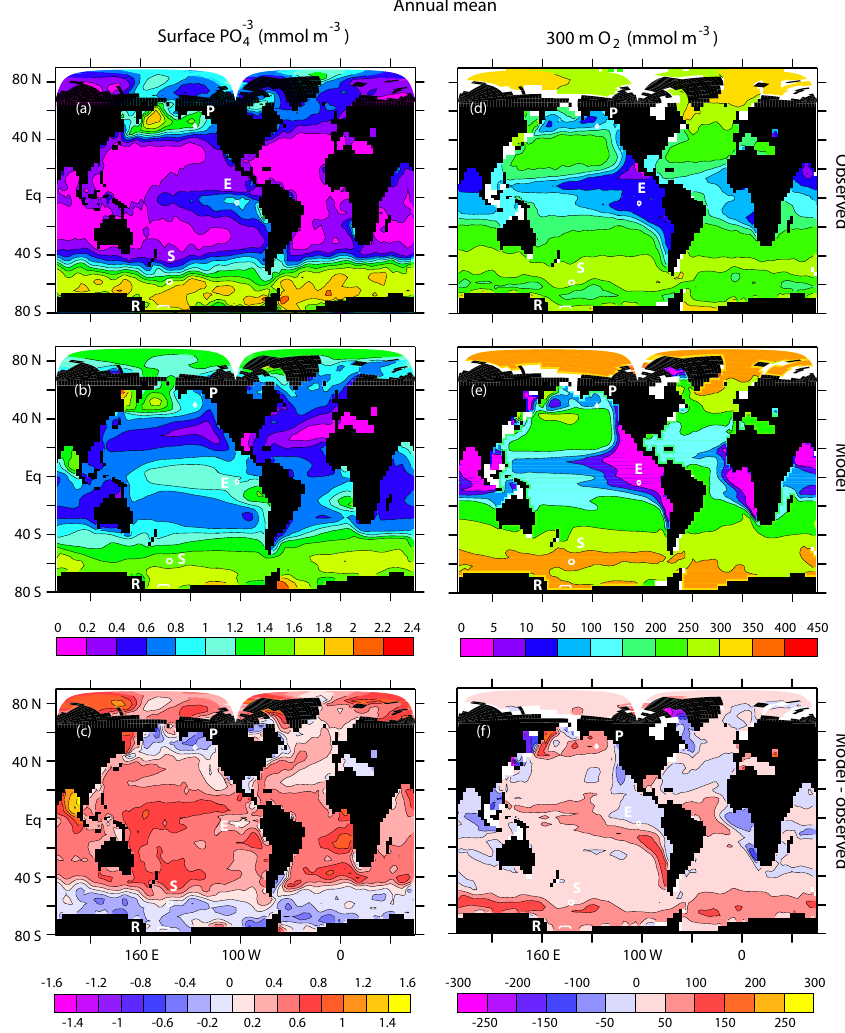
Fig. 2. (a) Observed annual mean of the phosphate at the surface of the ocean inmmolm − 3 (Garcia et al., 2006) compared with (b) surface phosphate in the model. (c) shows the difference between model and observed. (d) and (e) show the oxygen concentration at 300m inmmolm − 3 in the observations and model simulation, respectively, and (f) shows the model minus observed oxygen distribution. The figures also show the location of the four iron fertilization sites discussed in the paper. P is the PAPA site, E is the Equatorial Pacific site, S is the Southern Ocean site, and R is the Ross Sea site (see Table 2). Table 2. Patch locations, bottom depth, and fertilization time in the 1x, 10x, and 100x